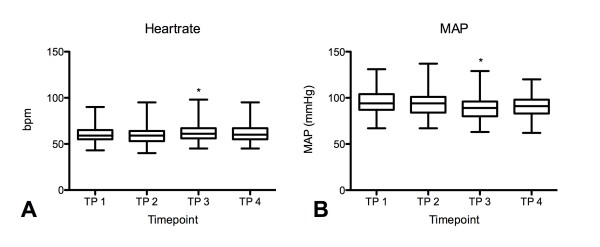
At T3-one minute after intubation-heart rate increased (P < 0.029) (Figure 3A) and ABP decreased (P < 0.001) (Figure 3B). Both changes were judged clinically irrelevant. Five minutes after tracheal intubation (T4) no more differences to the baseline values could be detected (n.s.). Data are presented as means ± standard deviation.